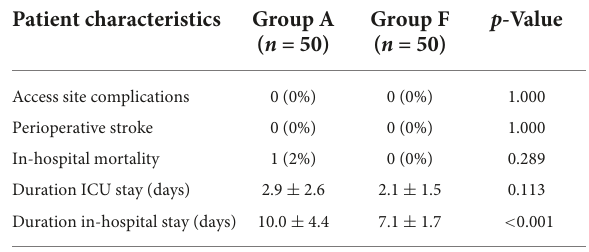
TABLE 3 Postoperative patient